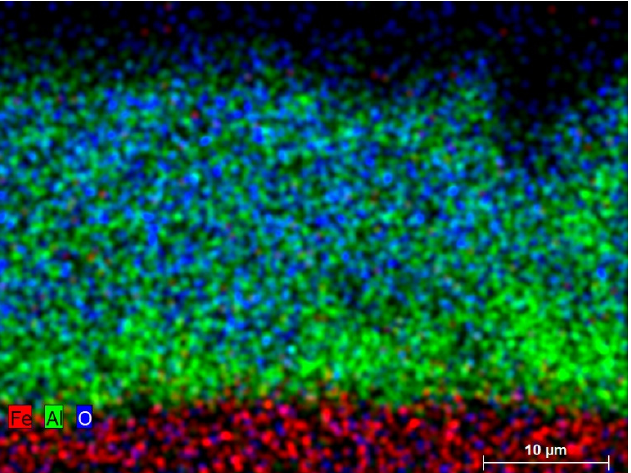
Figure 8. Elemental distribution maps of a cross-section of Al 2 O 3 coatings formed using 45.1 kW power.